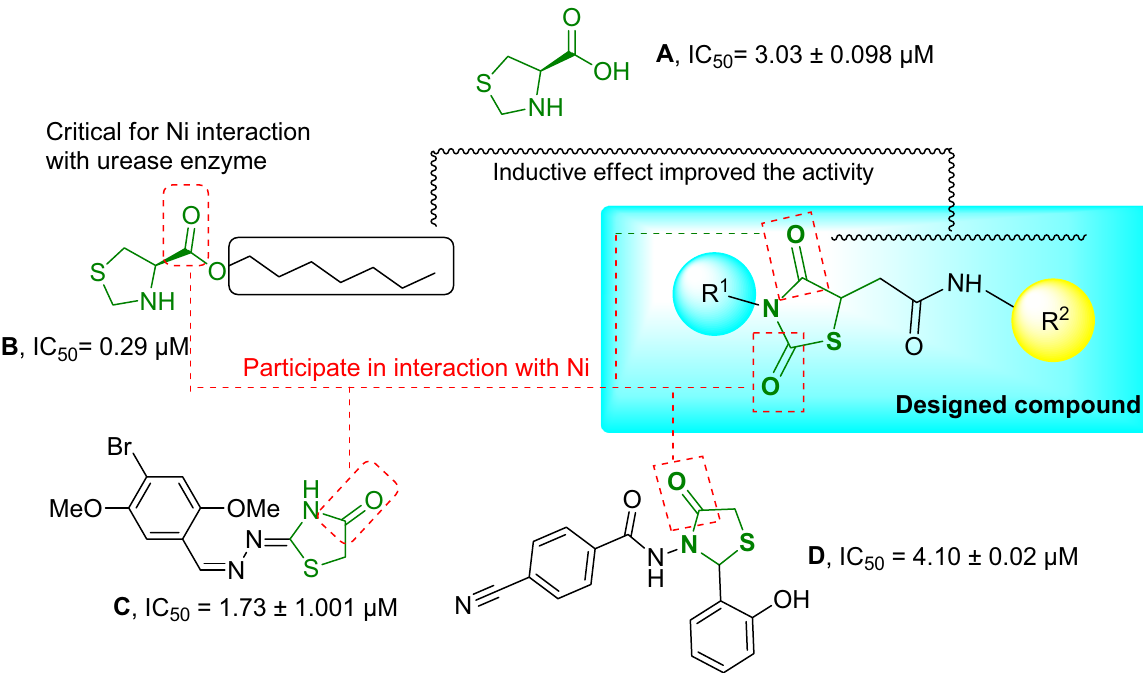
Figure 1. Rational design for the synthesis of novel thioxothiazolidinyl-acetamide as the urease